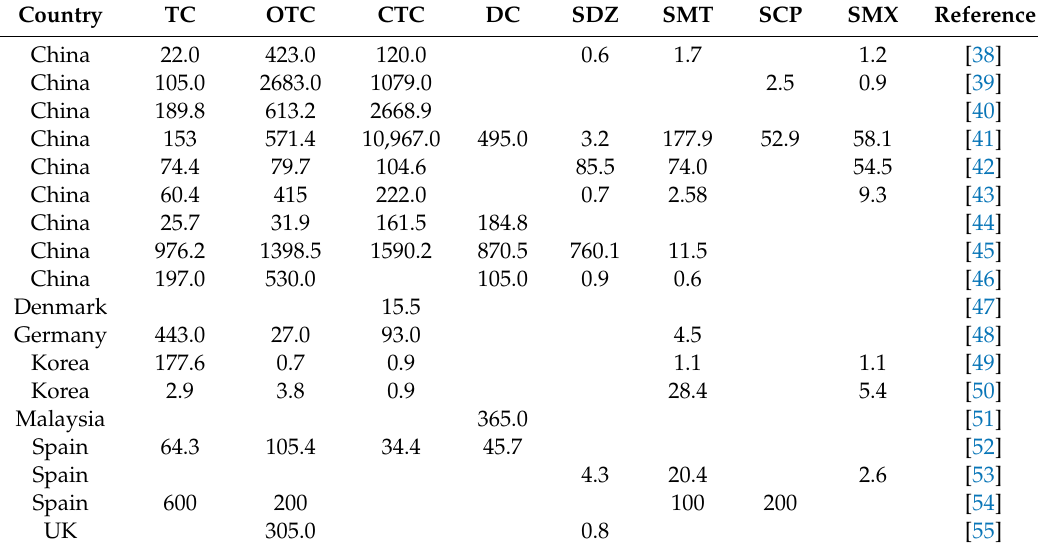
Table 5. Maximum concentration values ( µ g kg − 1 ) for tetracycline and sulfonamide antibiotics detected in agricultural soils of di ff erent